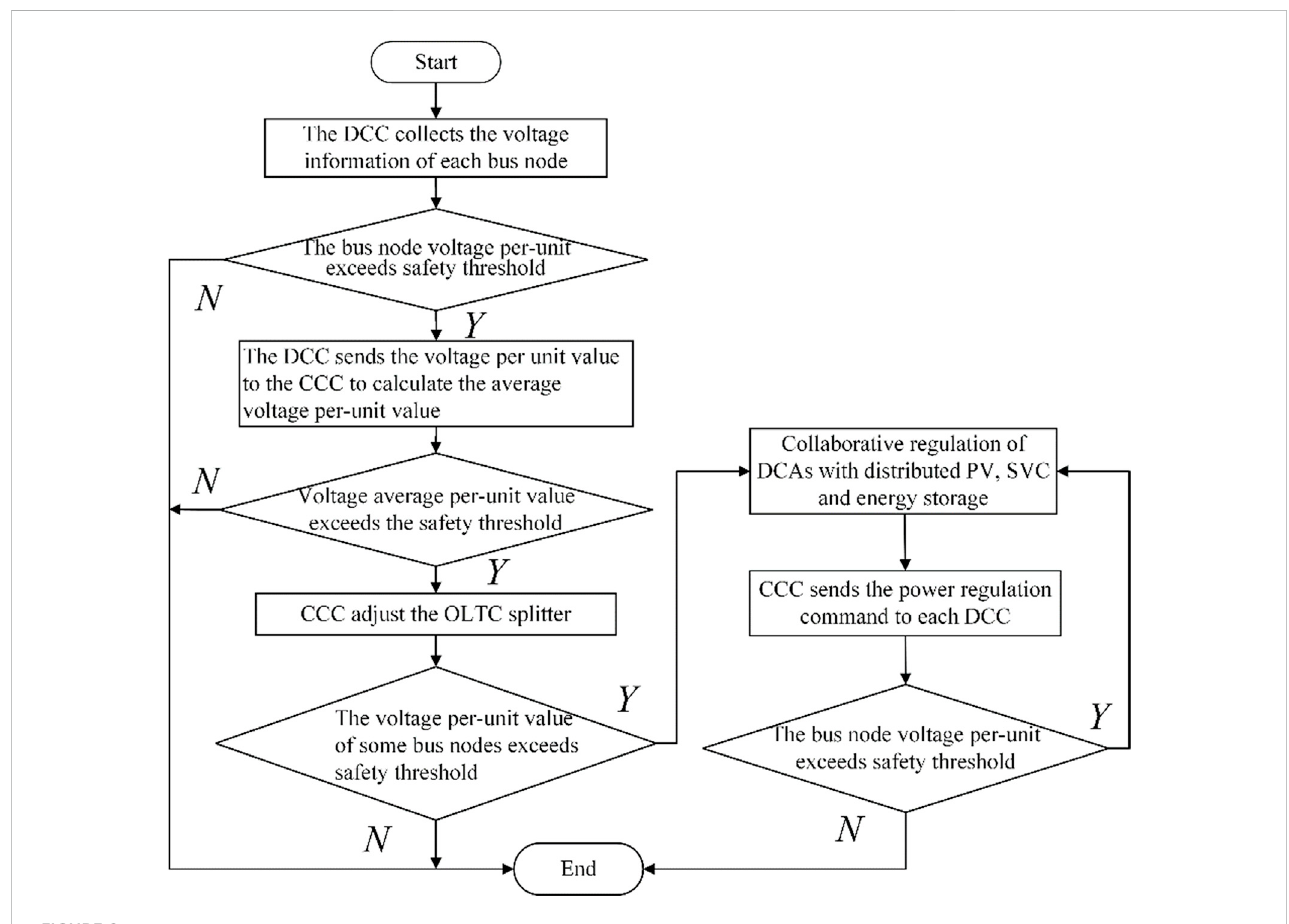
FIGURE 2 Overall framework of the cooperative voltage control strategy.